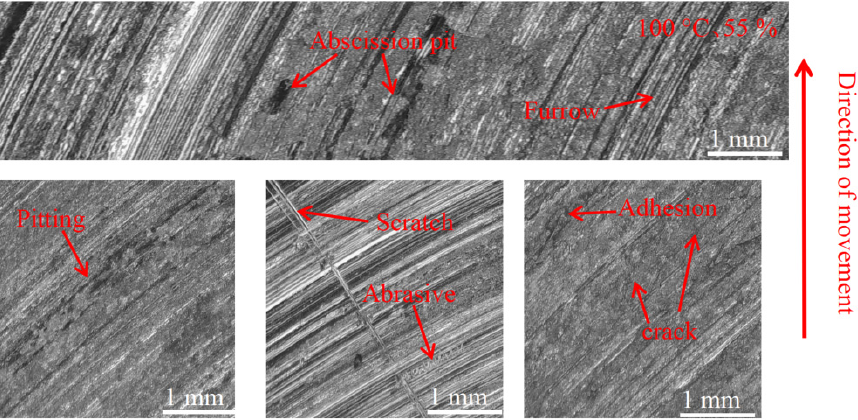
◦ C and 55% ambient humidity.